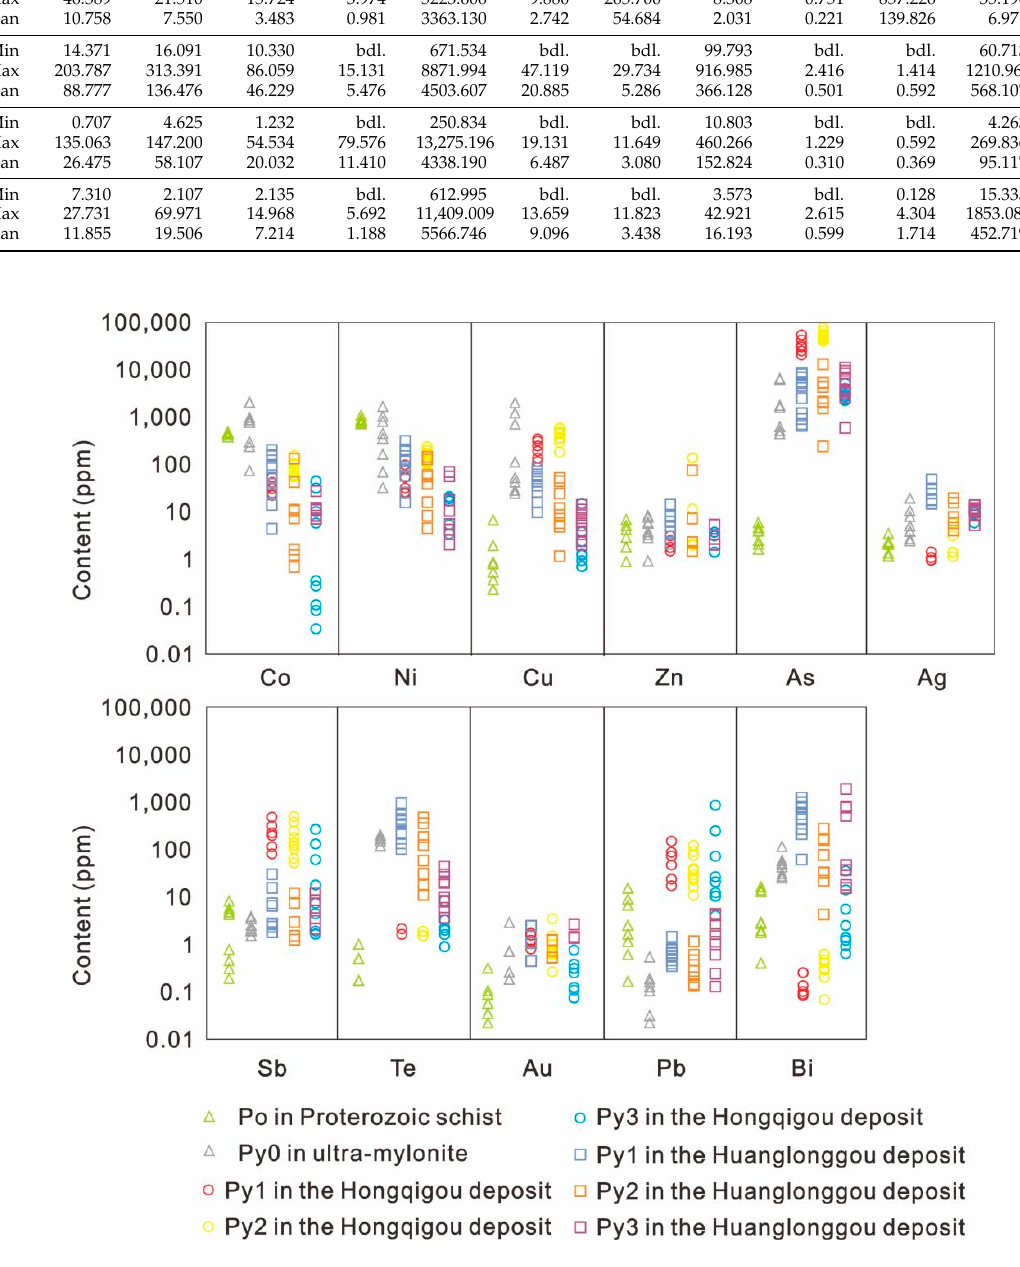
Figure 12. The variation ranges of trace elemental contents in pyrite and arsenopyrite determined by LA-ICP-MS.